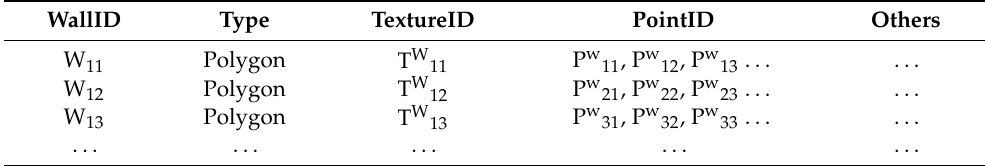
Table 8. The relationship of building wall